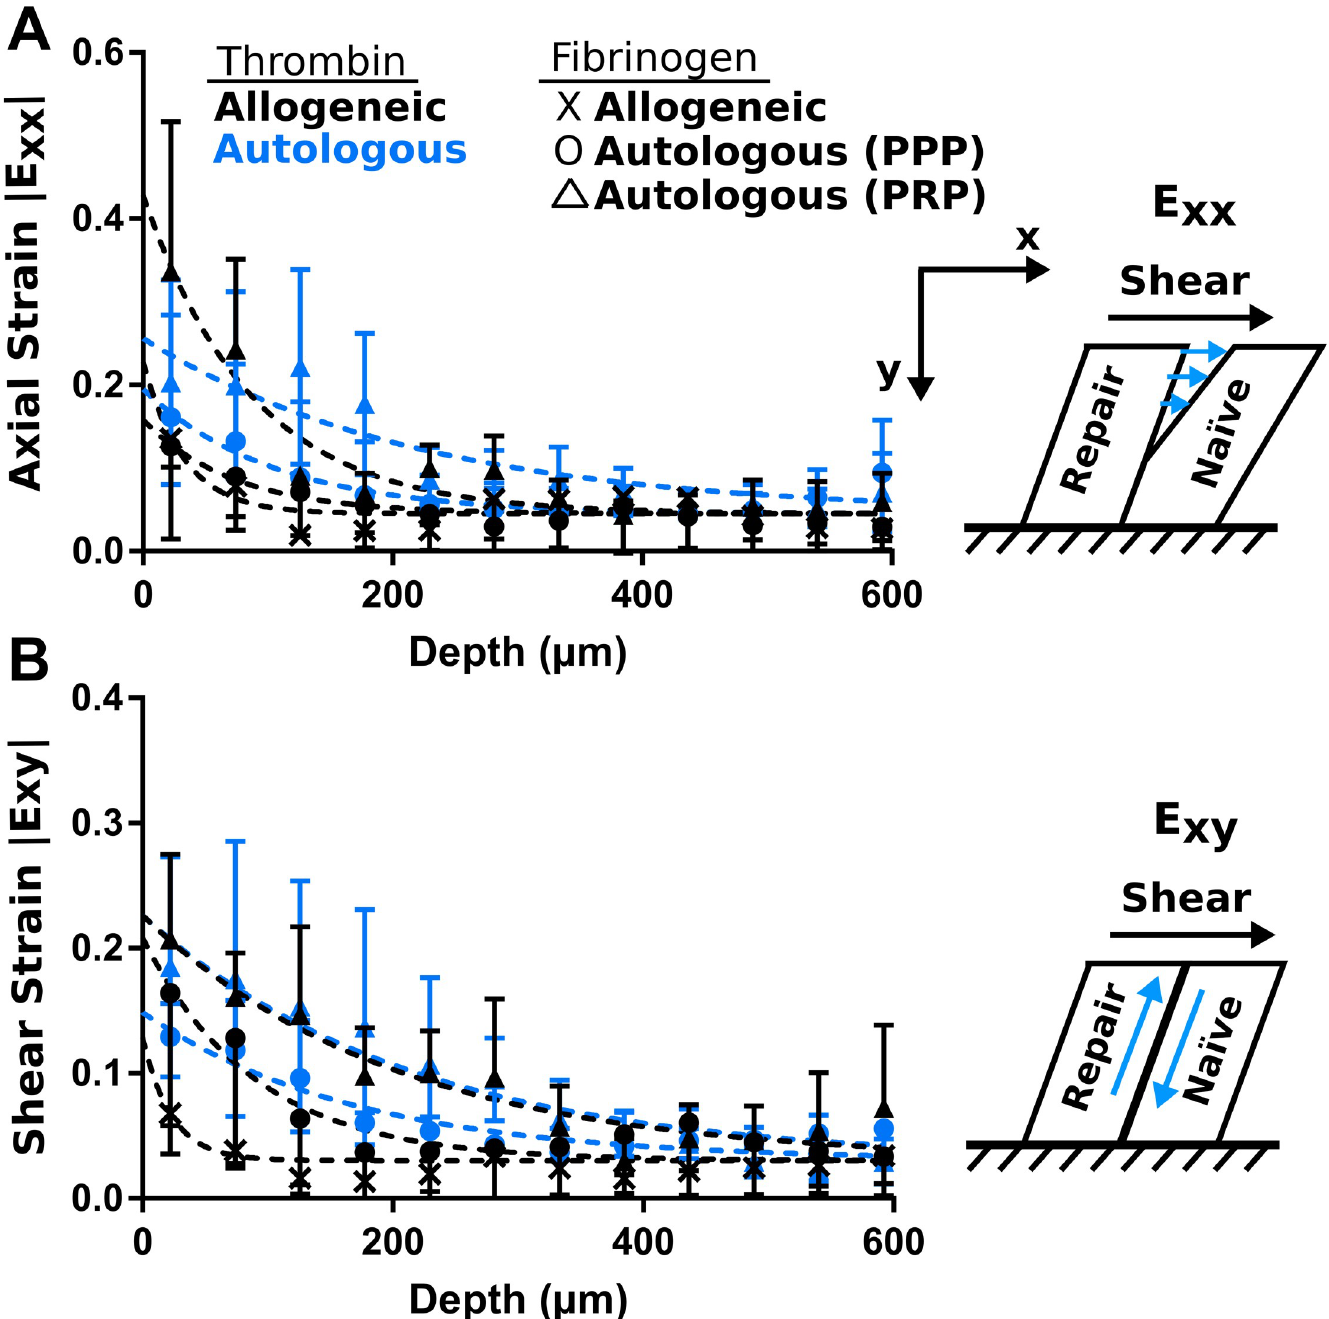
Fig 6. Strains are highest at construct surface and similar between sealants. Axial strains (a) and shear strains (b) are highest at construct surface and decrease with depth. Higher strains indicate pulling apart (axial, E xx ) or sliding (shear, E xy ) at the interface. Averages of individual samples plotted ± standard deviations (n = 2–4 per sealant). Exponential fits shown by dashed lines for strain averages. Strains are